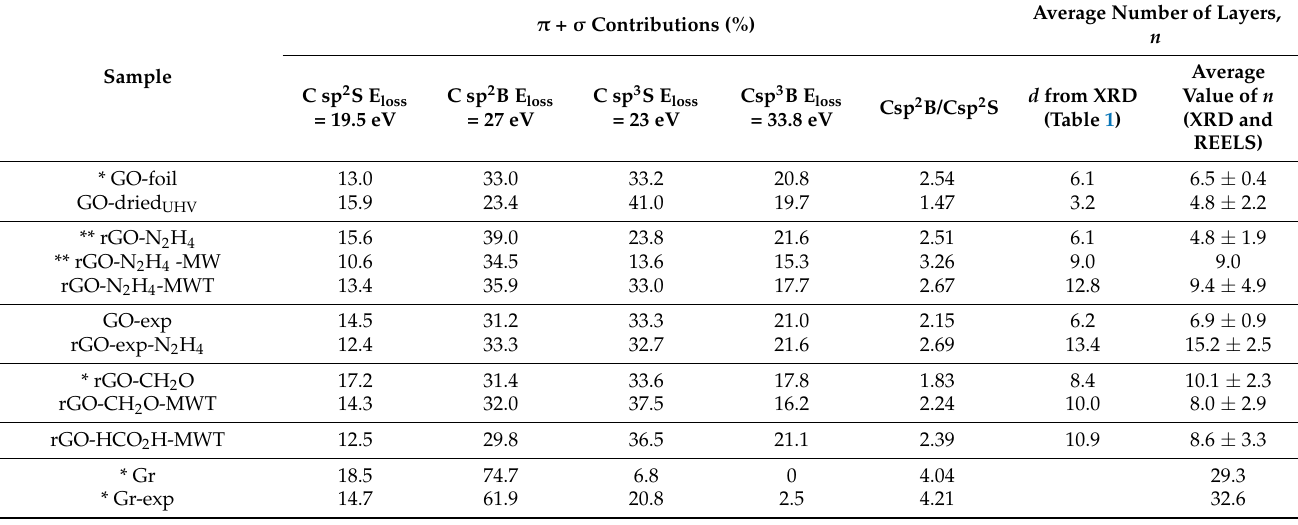
π + σ Contributions (%)